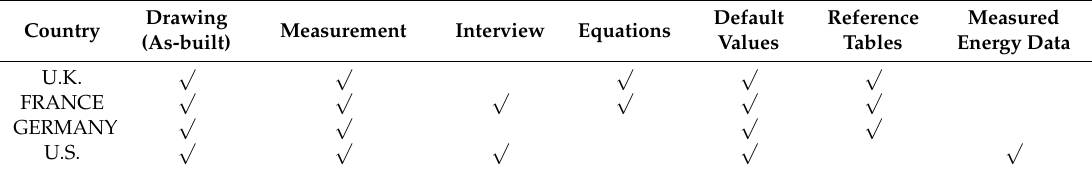
Table 1. Data utilized by countries for assessing of existing